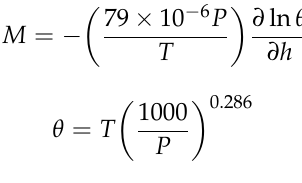
Table 3. Working conditions of the instruments.